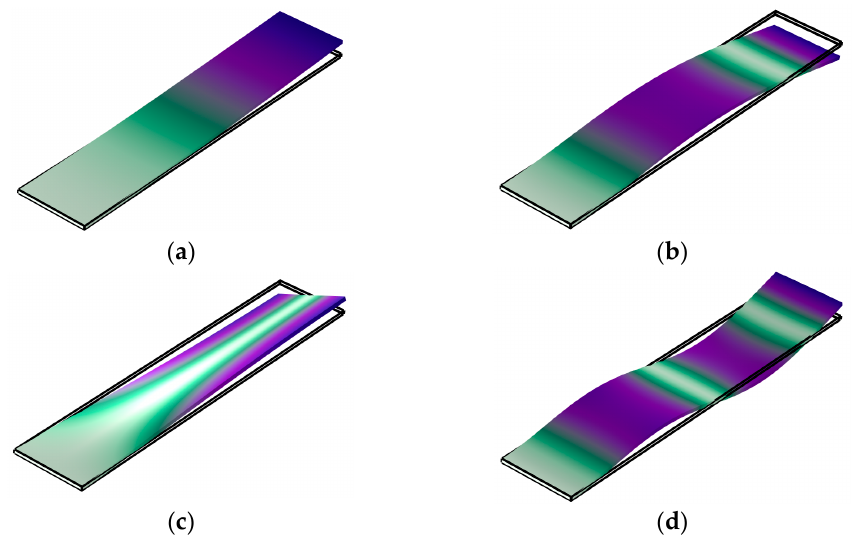
Figure 9. The eigenfunctions of the lowest four modes having the lowest eigenfrequencies: ( a ) 1st order mode, ( b ) 2nd order mode, ( c ) 3rd order mode, ( d ) 4th order mode.